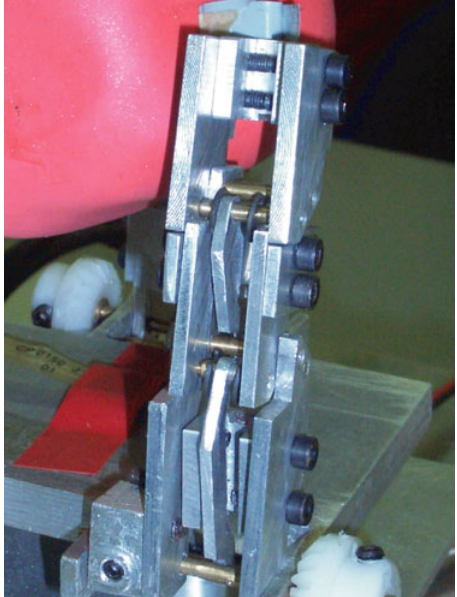
Figure 1 The new 1 d.o.f. finger prototype designed at LARM in Cassino.